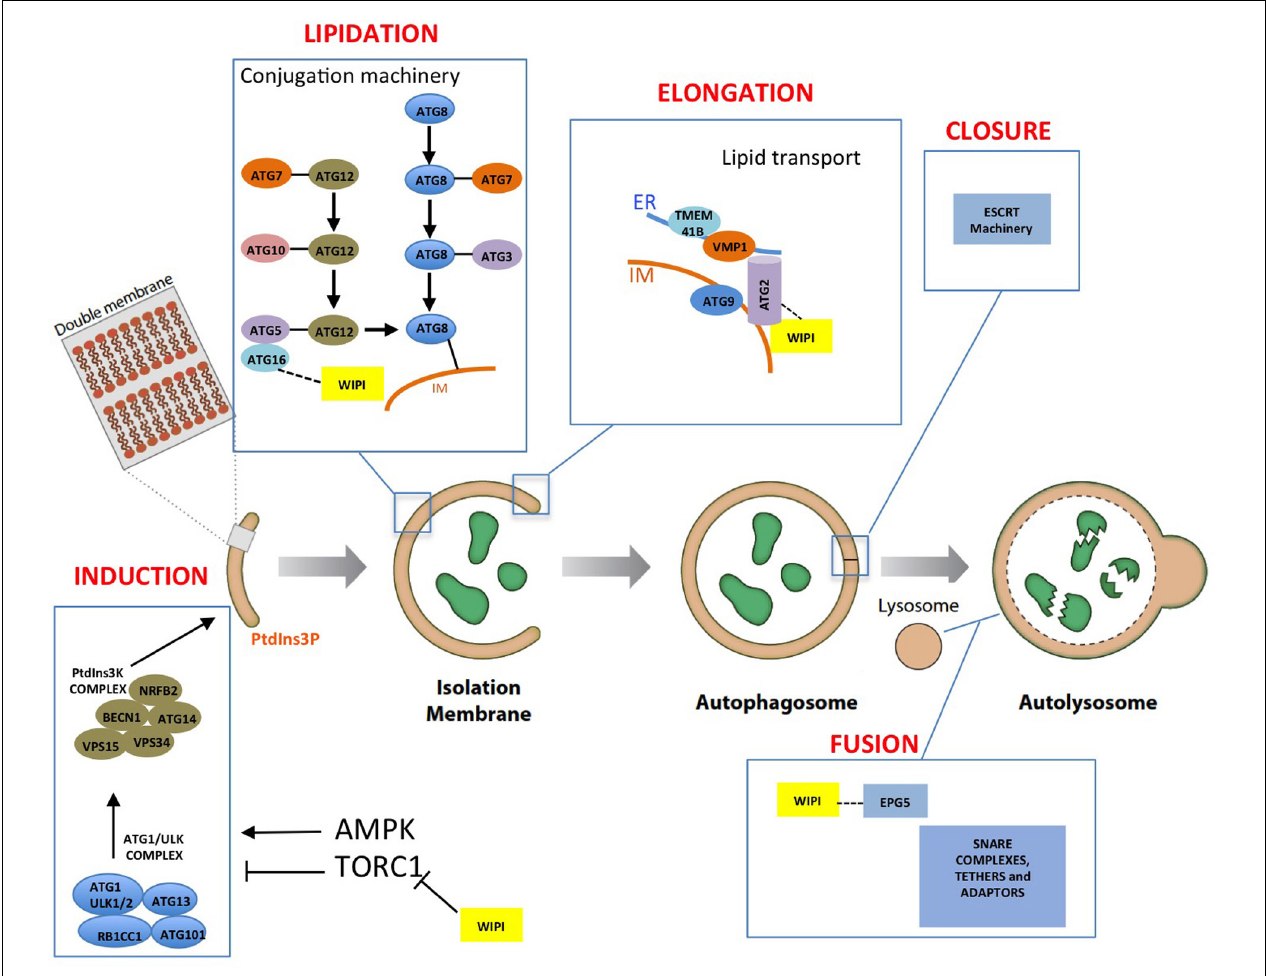
FIGURE 1 | Autophagosome formation and the autophagic machinery. The different steps of autophagosome formation are shown together with the proteins and protein complexes involved in autophagy regulation. WIPIs (yellow boxes) are involved in different steps of autophagosome formation (see the text for a detailed explanation of the specific WIPIs involved in each